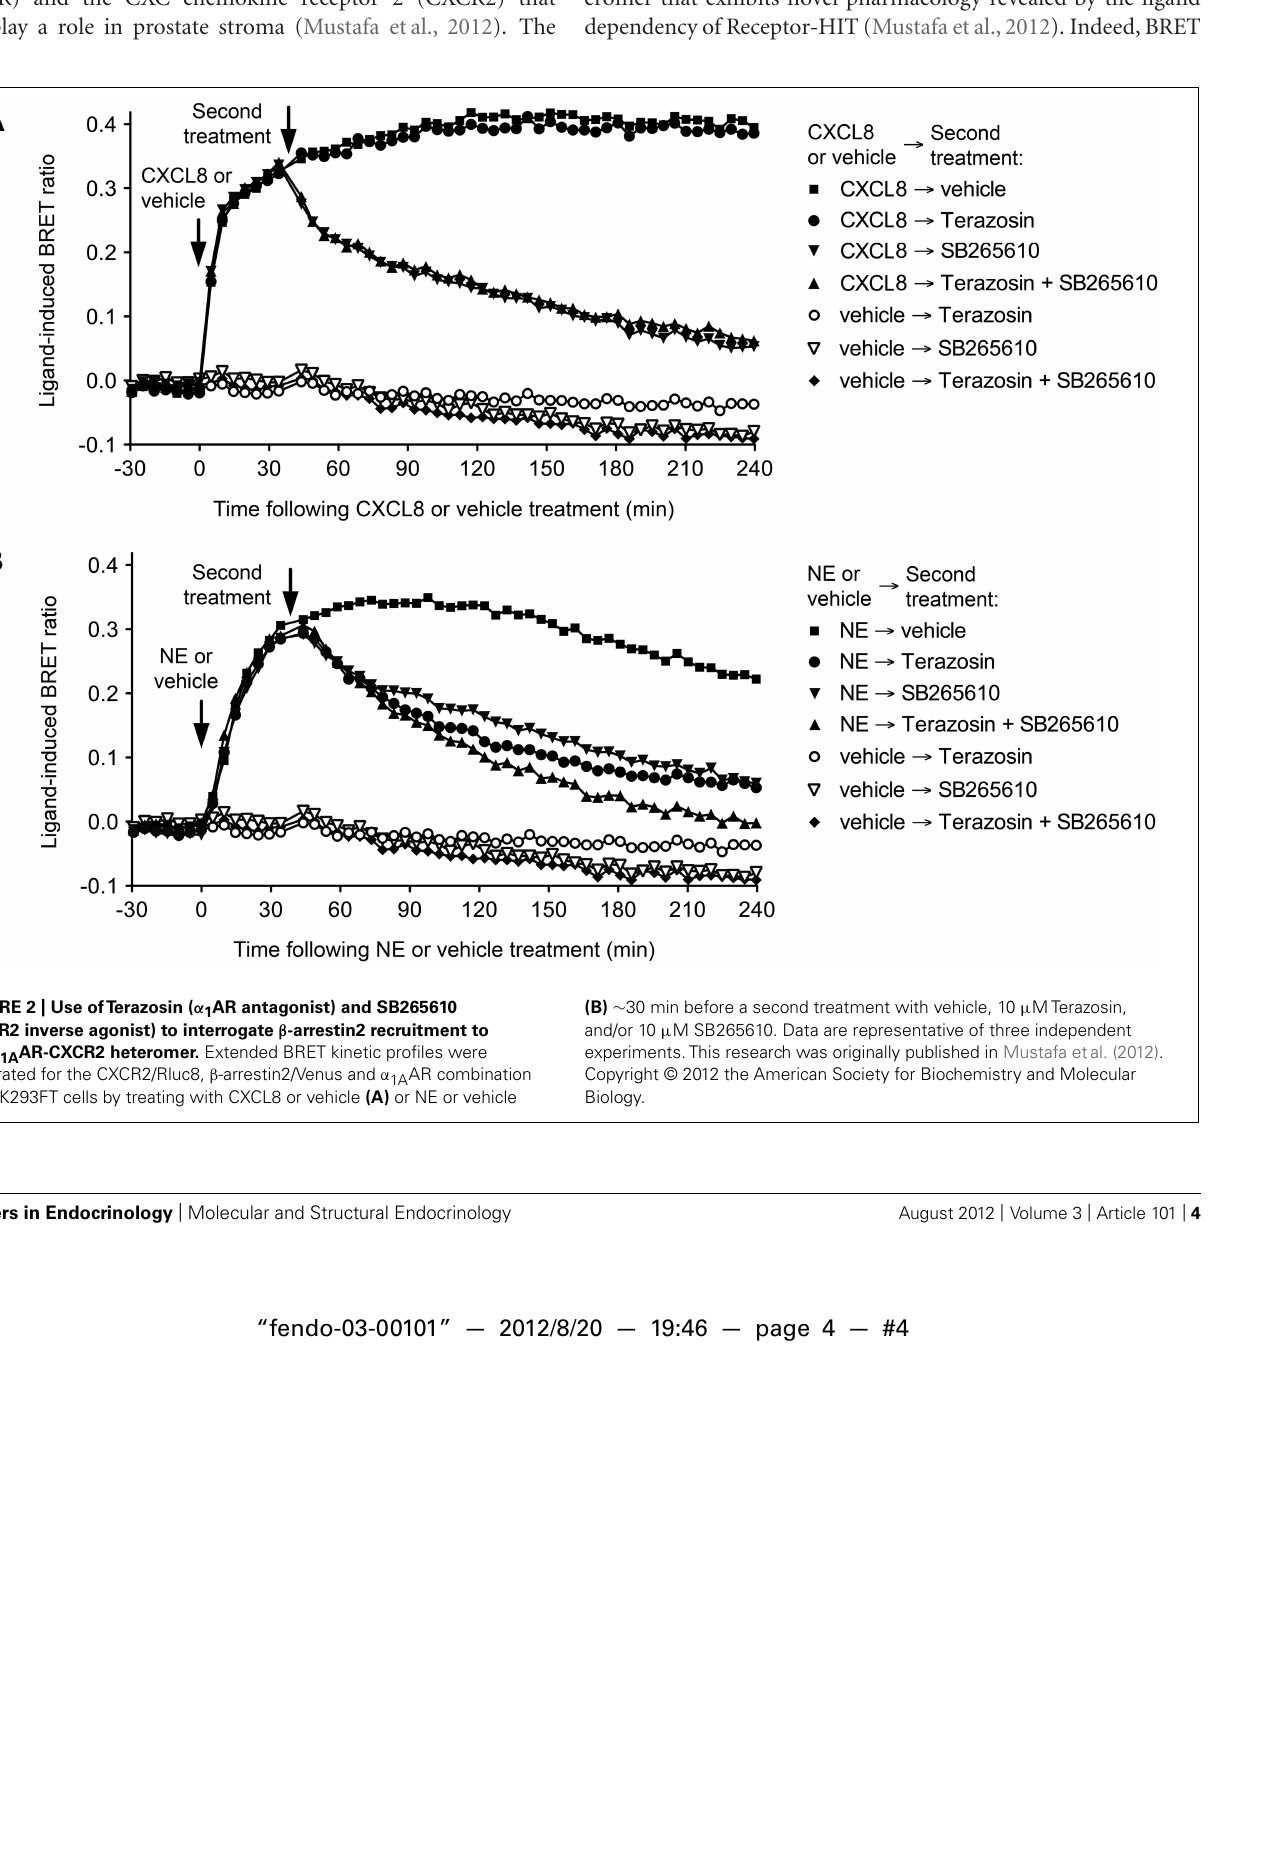
(B) ∼ 30 min before a second treatment with vehicle, 10 μ MTerazosin, and/or 10 μ M SB265610. Data are representative of three independent experiments.This research was originally published in Mustafa etal. (2012). Copyright © 2012 the American Society for Biochemistry and Molecular